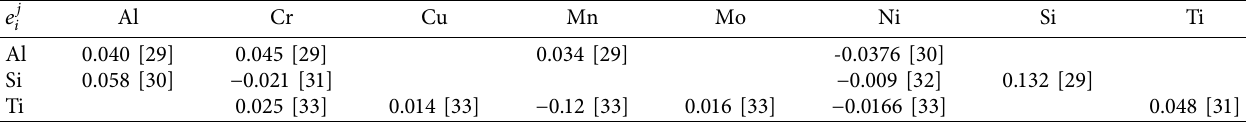
i of the constituent in the present